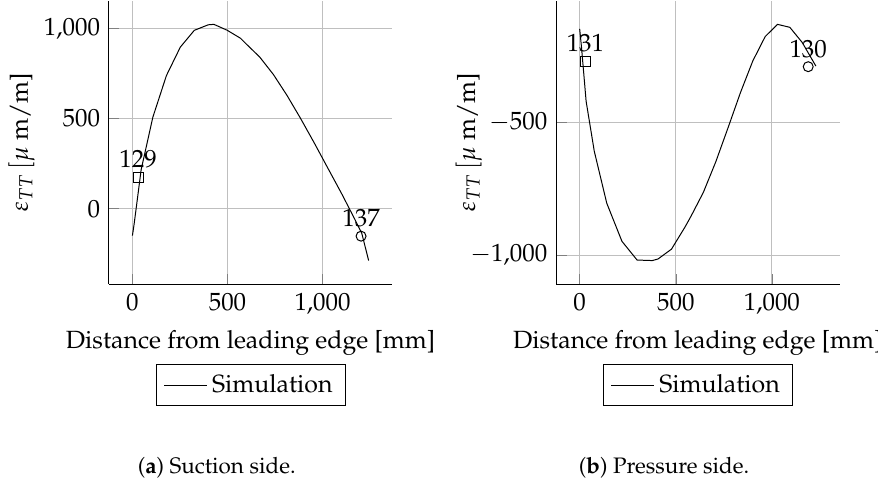
Figure A50. Strain comparison ε LL at radial position R = 15,000 mm for Mymin load